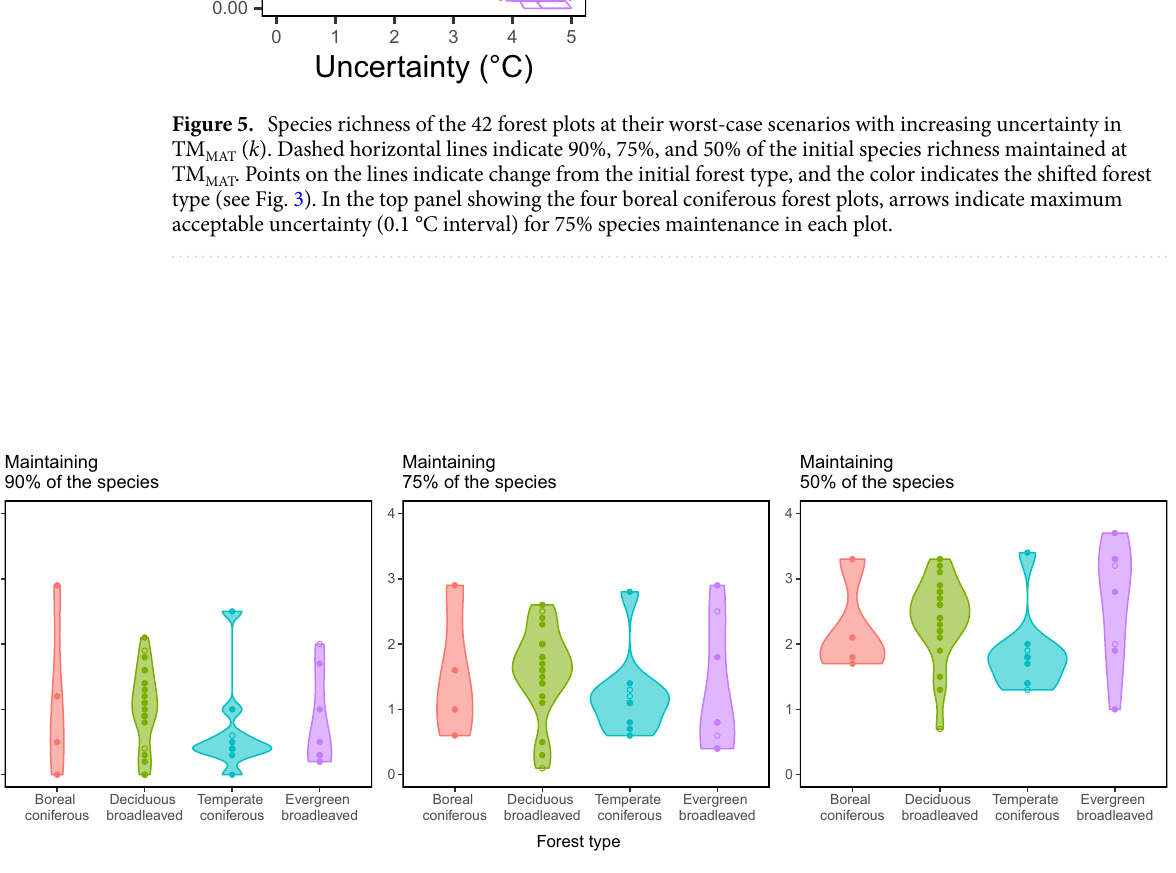
Figure 6. Acceptable uncertainty in TM MAT for species richness maintenance for different forest types with different conservational goals: 90%, 75%, and 50% of species richness maintenance. Filled circles, old-growth forest; empty circles, secondary forest. Violin plots illustrate distributions of all the forest plots in the